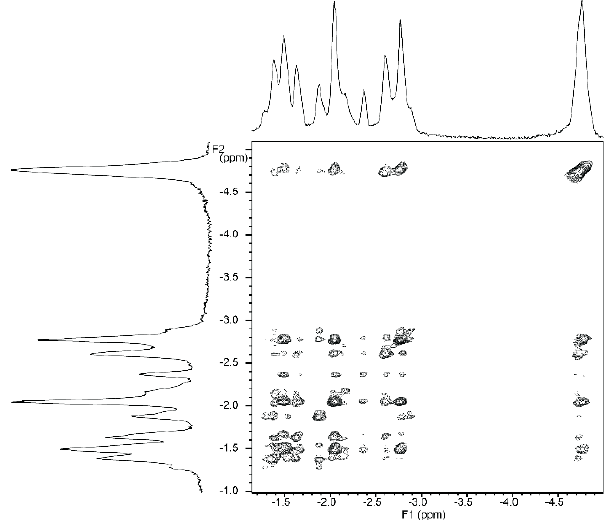
Figure 10. Expansion from TOCSY spectrum of a ≈ 1:1 complex of tweezer Z- 2 and 1,6-diaminohexane 21 (500 MHz, CDCl 3 . solution, − 40 °C).